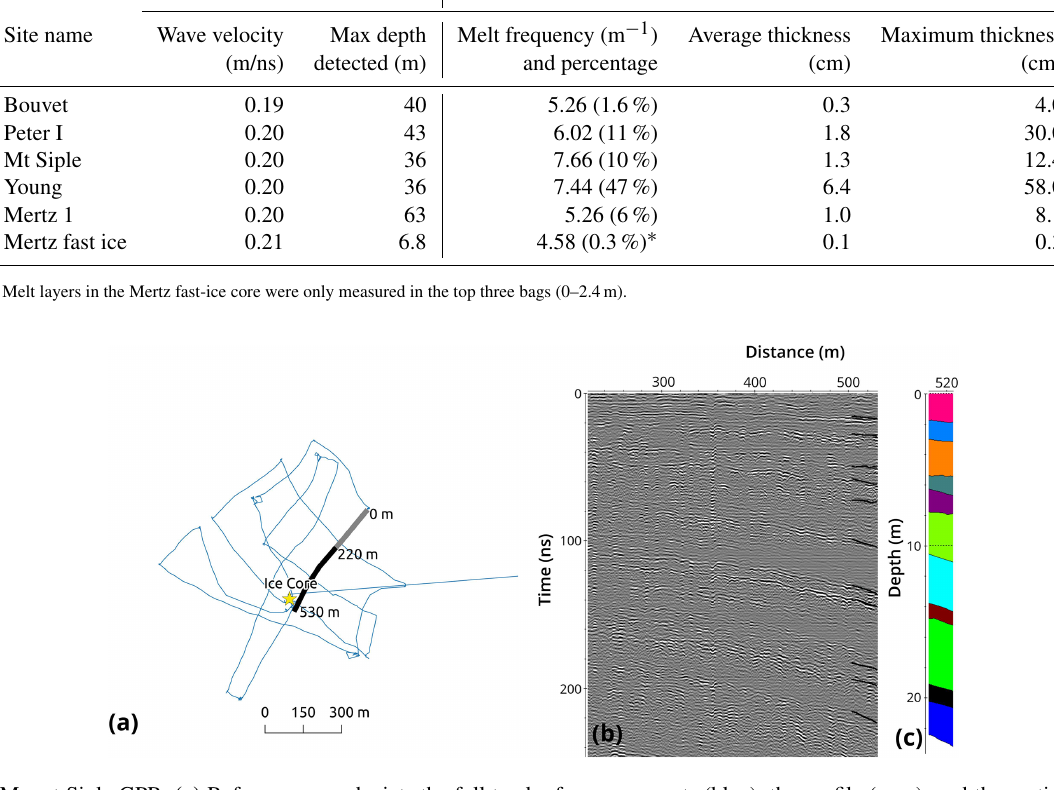
Figure 4. Mount Siple GPR. (a) Reference map depicts the full track of measurements (blue), the profile (grey), and the section shown in the radargram (black). (b) Radargram ending at the position of the ice core extraction (star) shown with layer interpretation and (c) estimated depth of